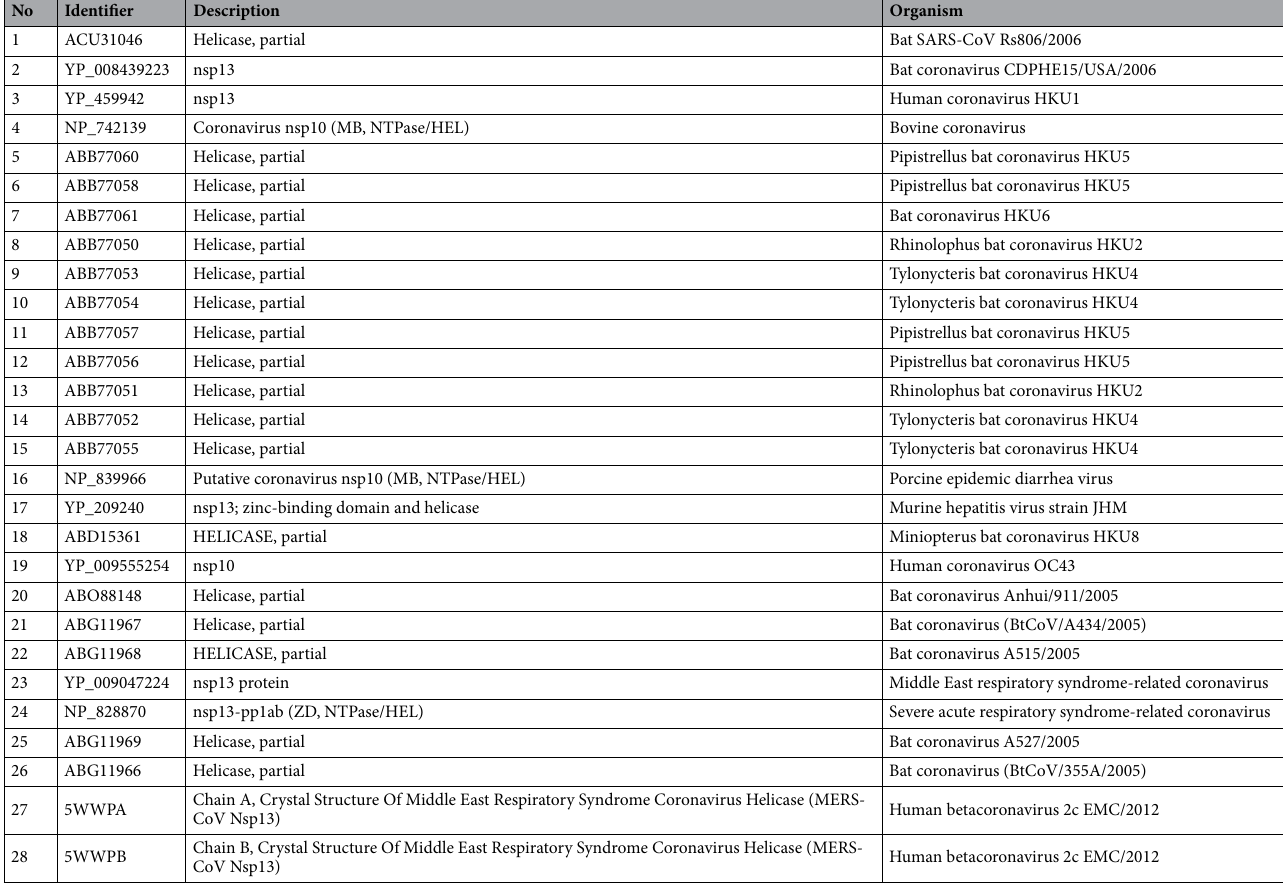
Table 1. Domain architecture conservation in viruses. CDART and SPARCLE tools were used to identify sequences sharing of domain architecture with our query (SARS-CoV-2 helicase) sequence. The search was refined to identify only human virus sequences, identified by NCBI identifier in column 2, which are shown in the Table. The Table also describes the nature of protein in all the shortlisted sequences and the organism to which they belong.